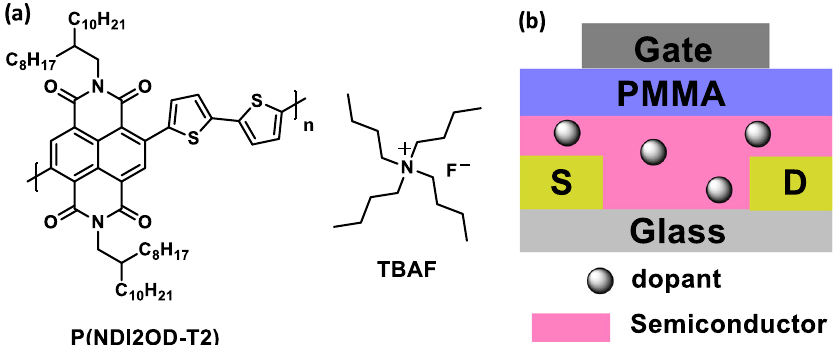
Fig. 1 a Structure of the matrix polymer P(NDI2OD-T2) and dopant TBAF for n-doping; b con fi guration of top gate/bottom contact OTFT device based on doped